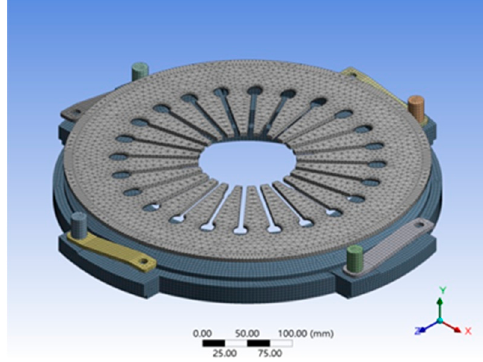
Figure 1. Simplified model of pressure plate assembly.